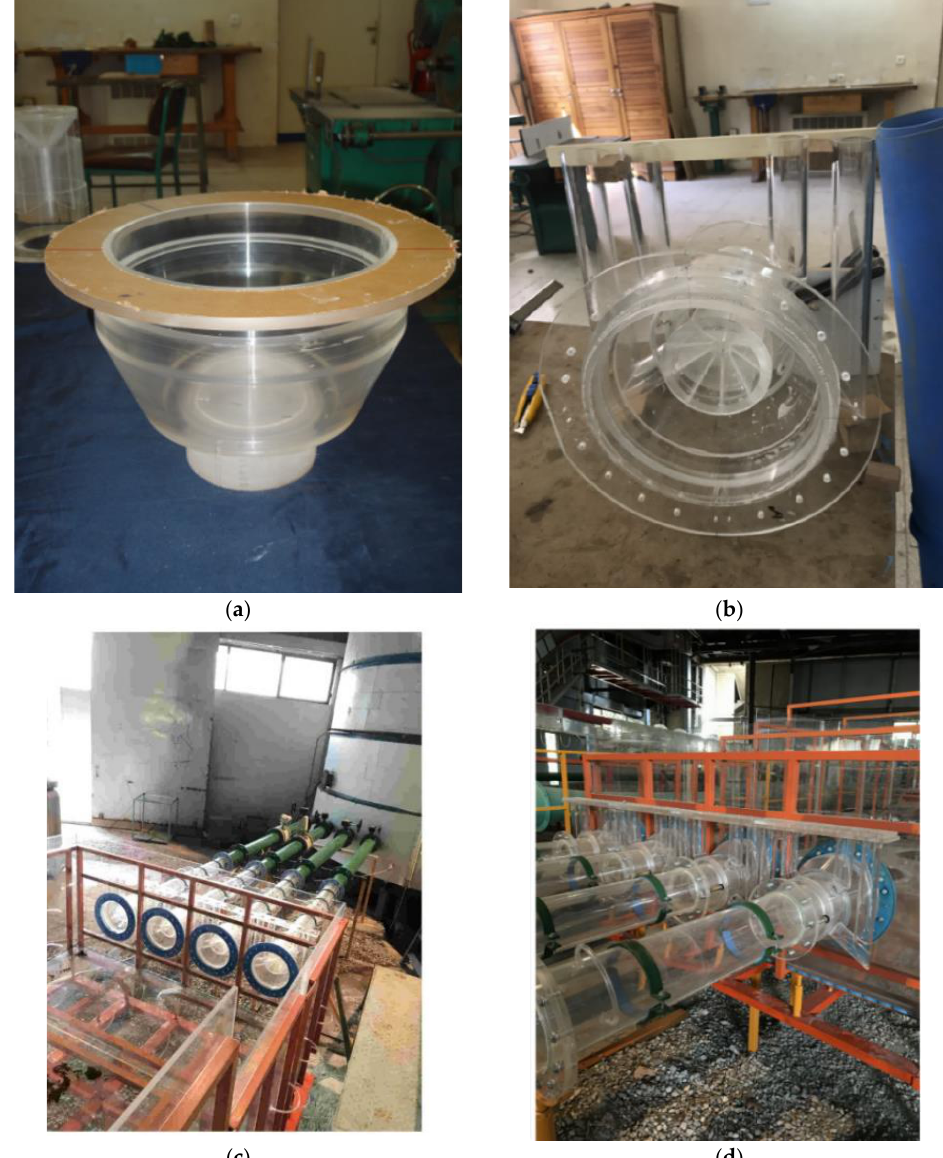
Figure 2. Preparation, construction, and installation of Howell – Bunger and other details of down- stream system in the physical model: ( a ) the geometric form of the plexiglass hood; ( b ) the geometric form of the plexiglass Howell – Bunger; ( c ) installation of the bottom outlets in the stilling basin; and ( d ) views from the physical model of the stilling basin.